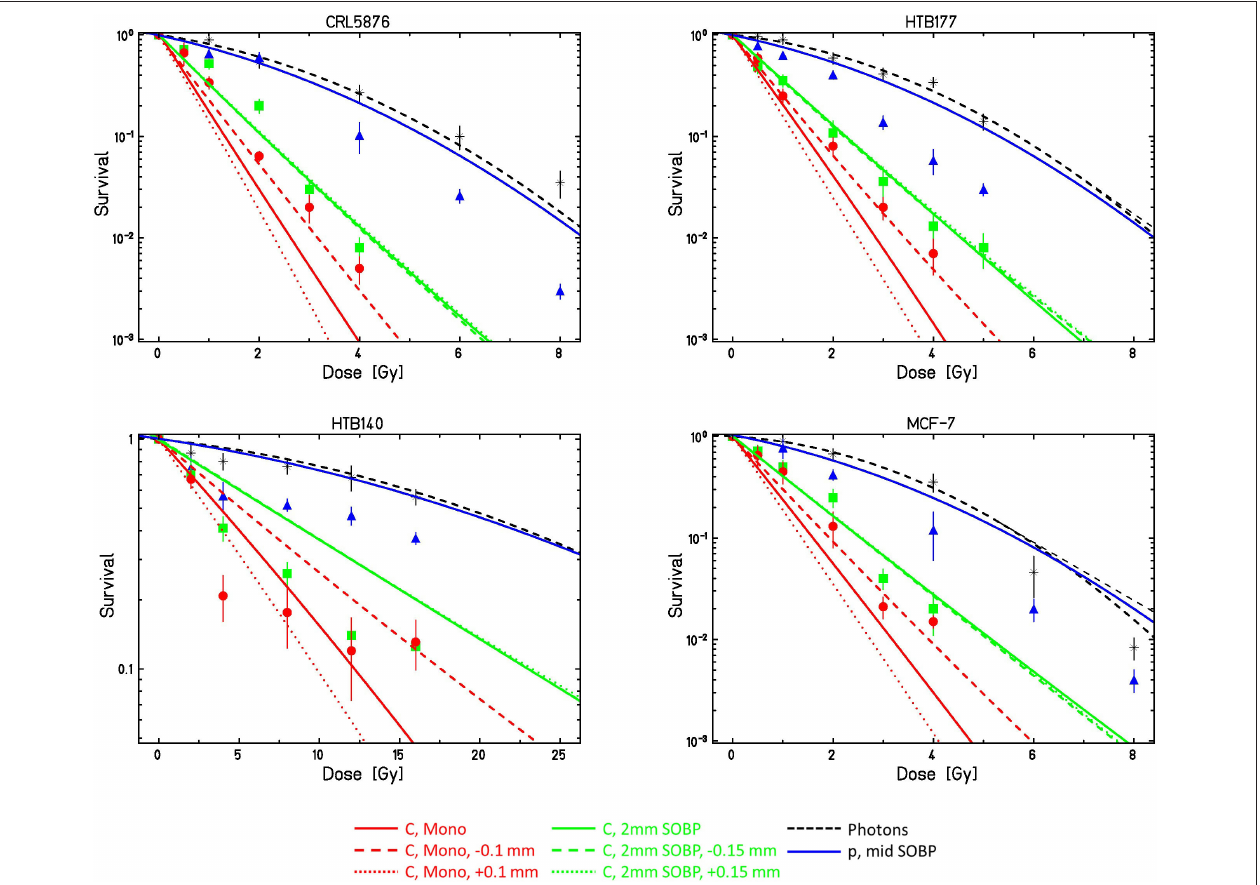
FIGURE 2 | Comparison of LEMIV model calculations (lines) with experimental cell survival data (symbols) obtained at the INFN-LNS beamlines with different cell lines and different radiation qualities. For details see text. Calculations for ± 0.1 and ± 0.15mm refer to potential positioning inaccuracies as compared to the desired depth.